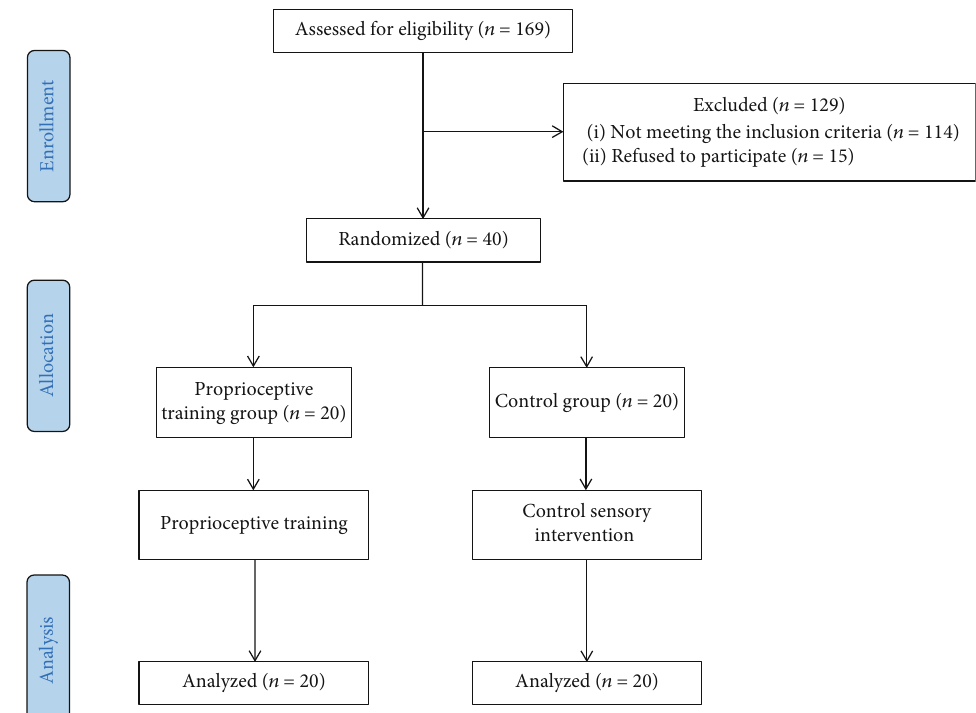
Figure 2: Flow chart of the participant selection and assignment in this